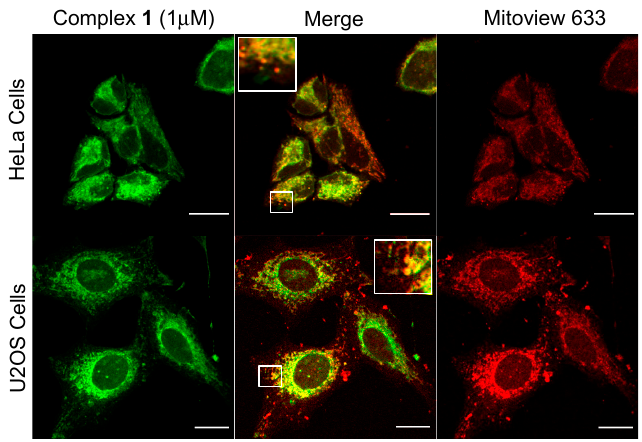
Figure 4. Confocal images of complex 1 Cl (green) following 4 h incubation in HeLa and U2OS cells co-localised with Mitoview 633 (red) with central overlaid image, scale bars 20 µ